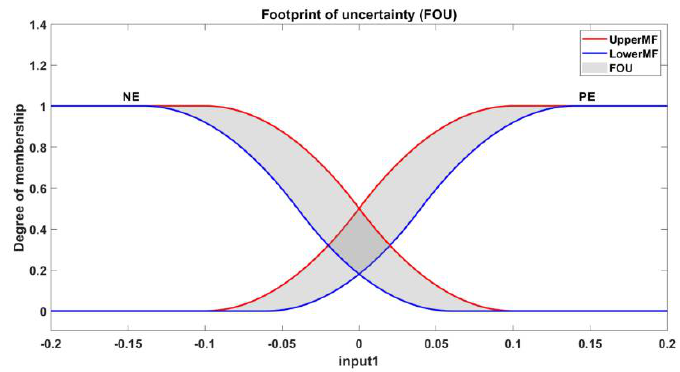
Figure 11. Footprint of uncertainty.